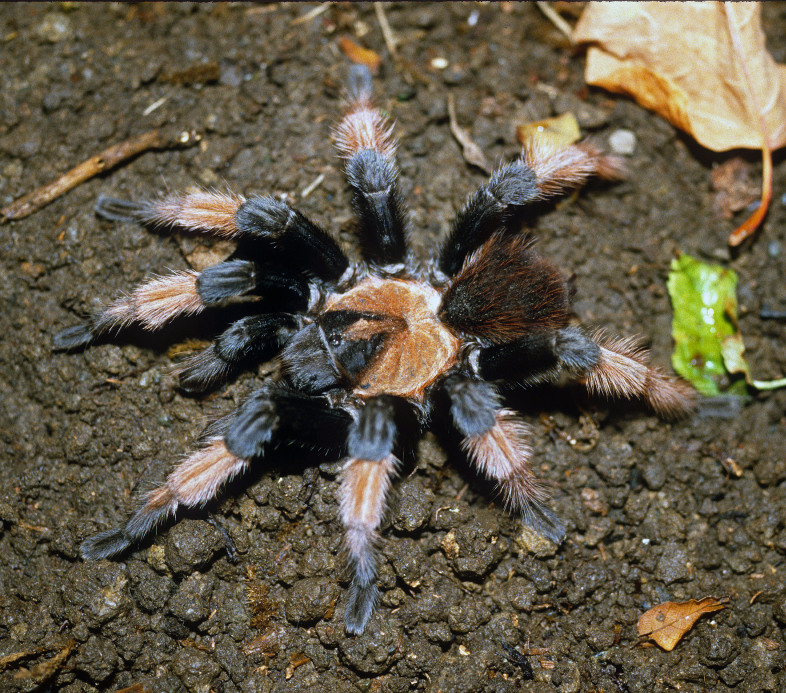
Brachypelma
emilia (White, 1856) male near Las Varas, Nayarit state, Mexico. Photo: Rick C. West.